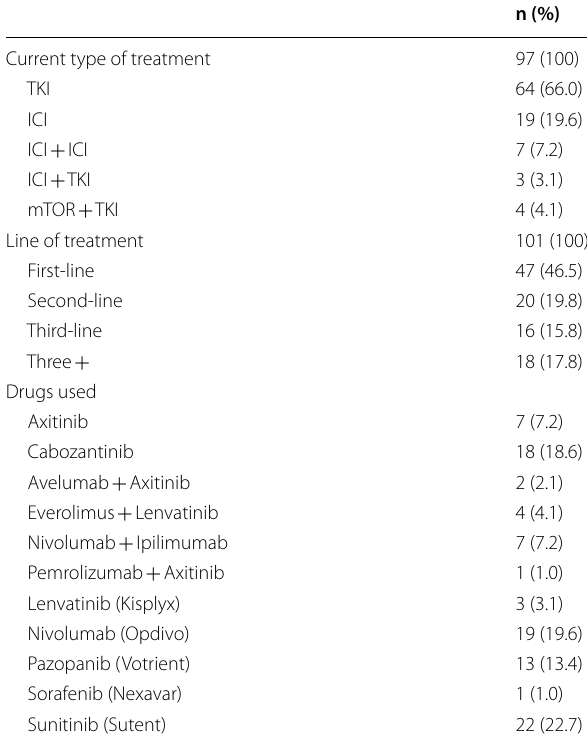
104) Table 2 Type of treatment (n =